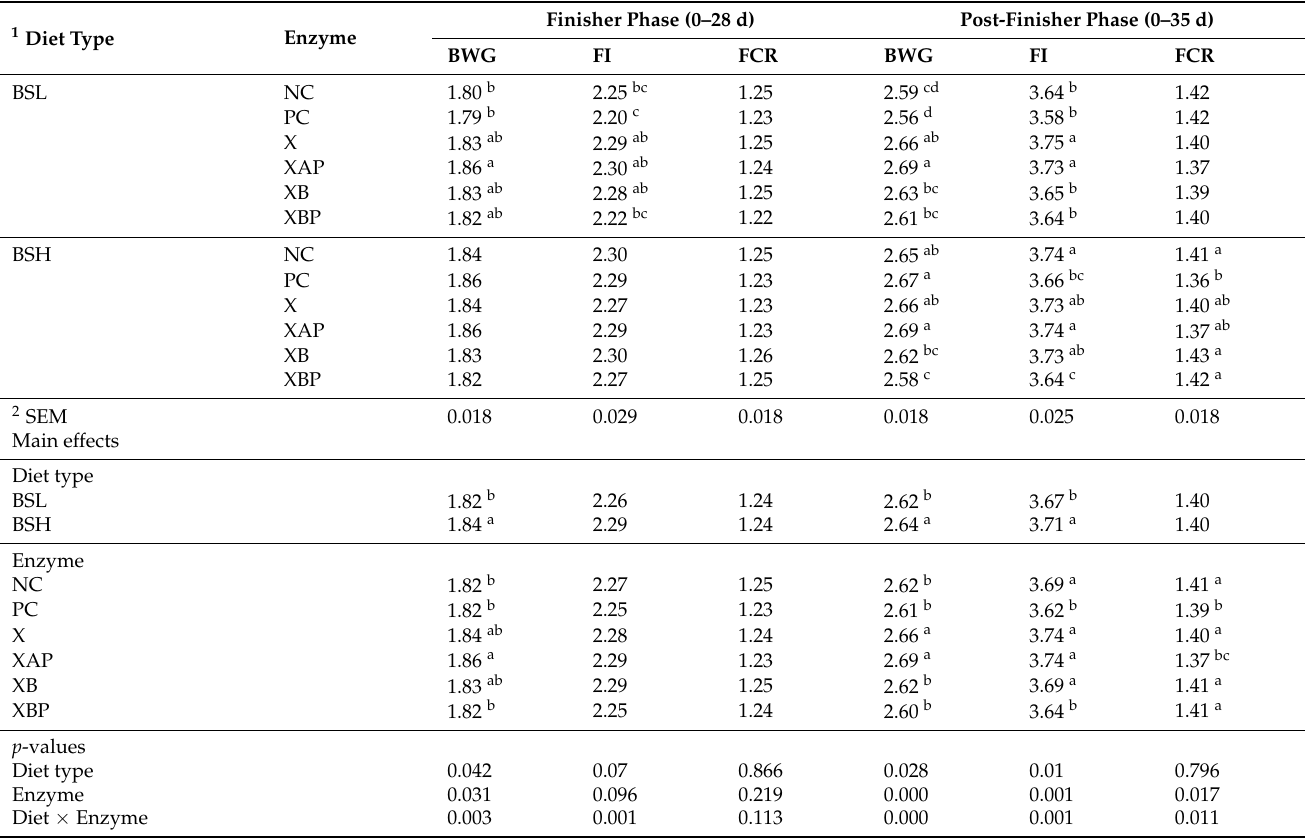
Table 6. Cumulative growth performance for broiler’s fed SFM-based diets with different